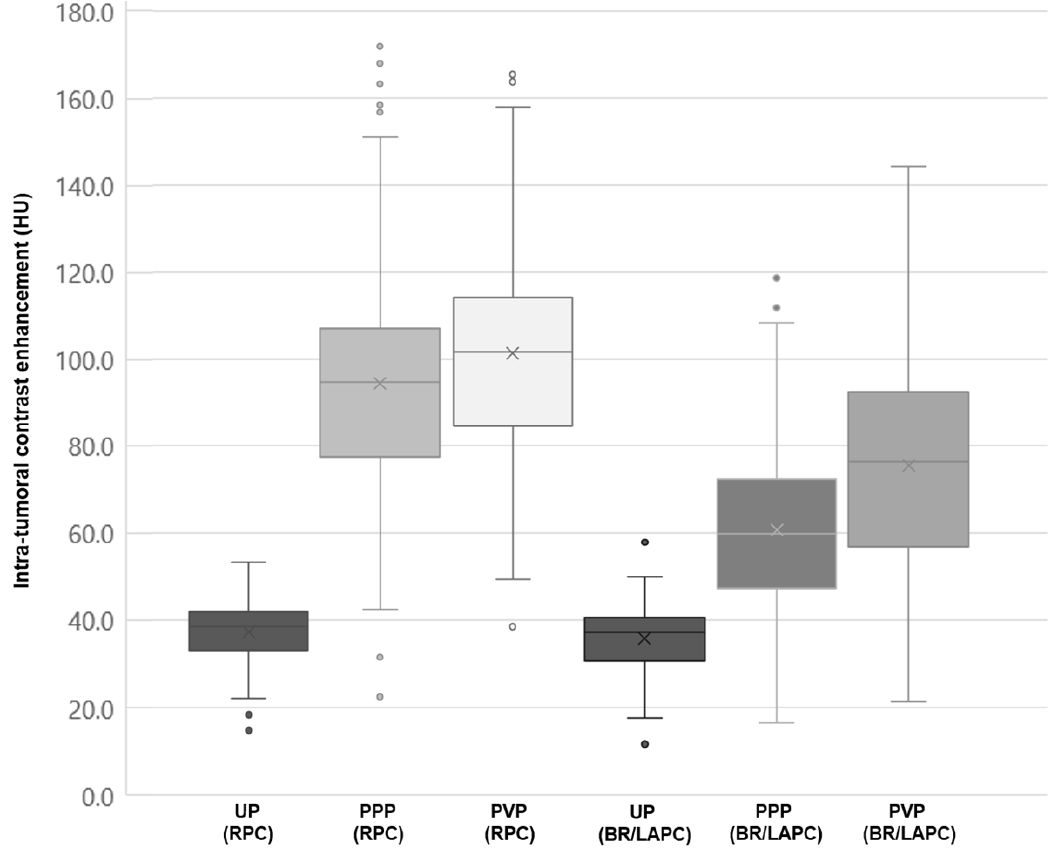
Figure 2. Intra-tumoral contrast enhancement in each phase. (x: median, dots: outliers)